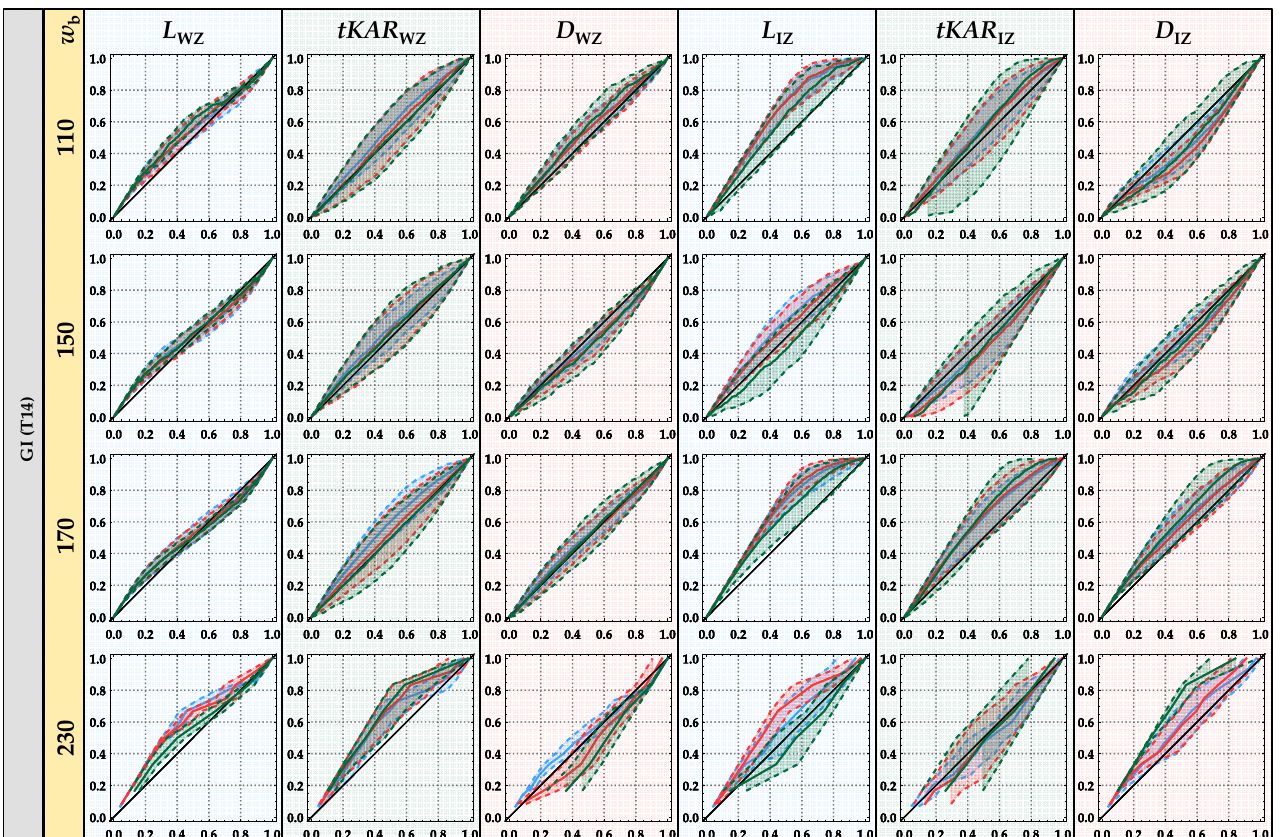
Figure 8. PP-Plots of model prediction (incl. 95% confidence interval) vs. empirical data from database for global (mean) board properties of unsplit boards ( η s = 1 in green) and lengthwise split boards ( η s = 1/2 in red; η s = 1/3 in blue).